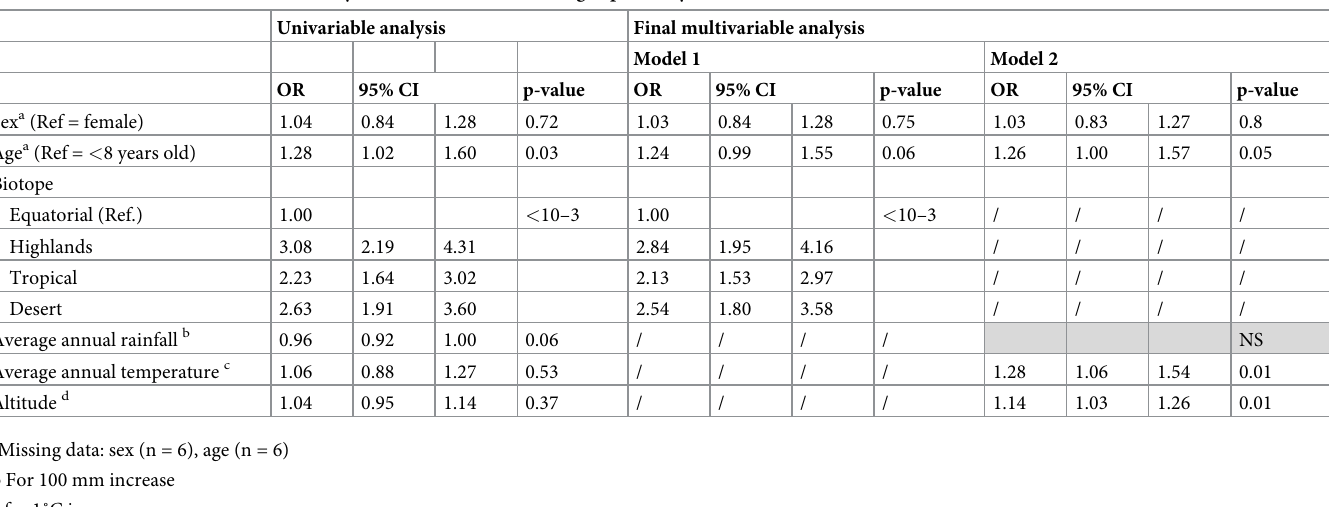
Table 3. Univariable and multivariate analysis related to T . solium antigen